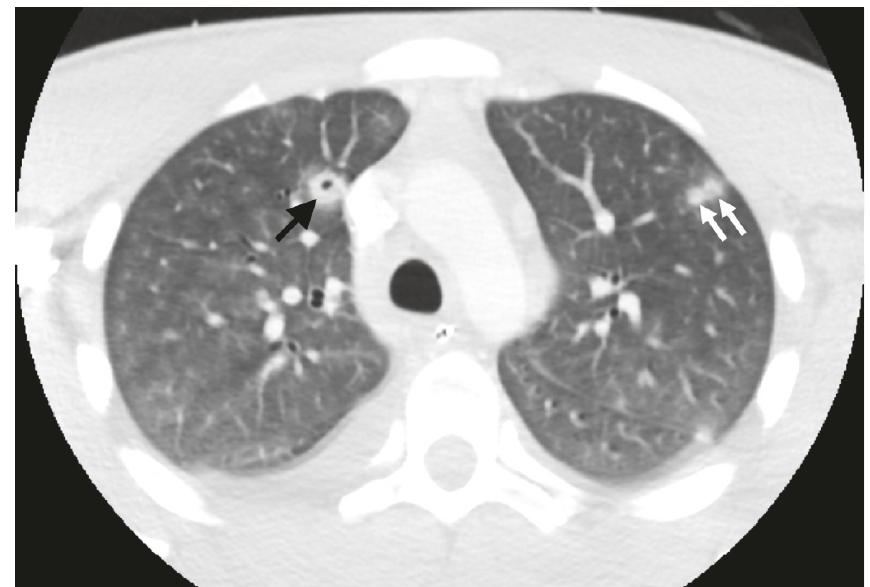
Figure 3: Axial image through the upper chest from CT scan of the neck. Multiple nodules were visualized in the imaged portion of the chest, including cavitary (black arrow) and noncavitary nodules (white arrows).